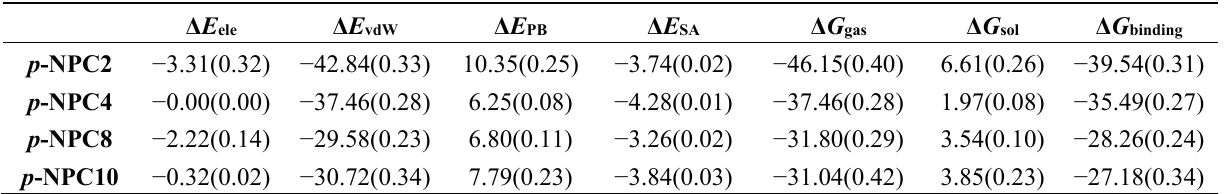
Table 7. Binding free energy (in kcal·mol − 1 ) for p -NP esters binding to P186_15588 *. Δ E ele Δ E vdW Δ E PB Δ E SA Δ G